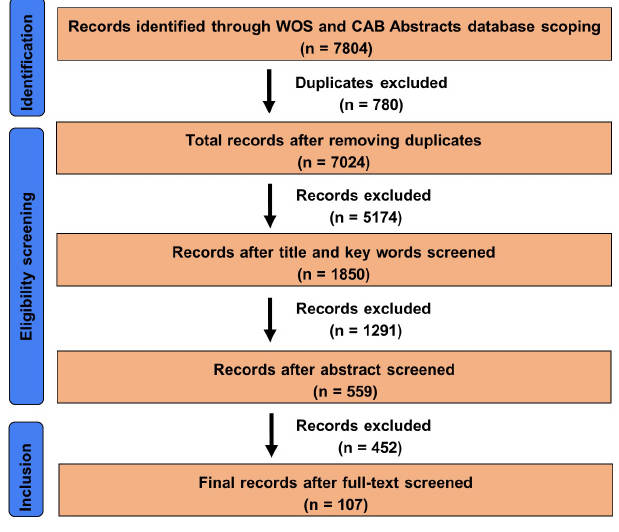
Fig. 1 . Flow diagram summarizing the number of studies included and excluded from the synthesis in the screening